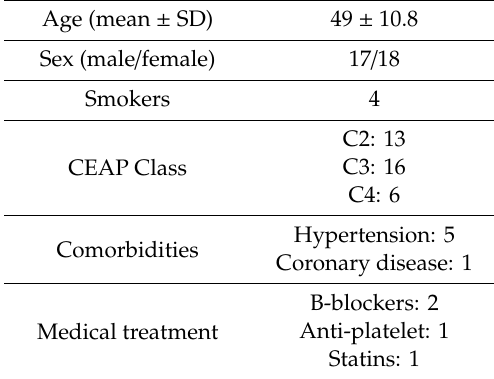
Table 2. Demographic data of recruited patients (n =